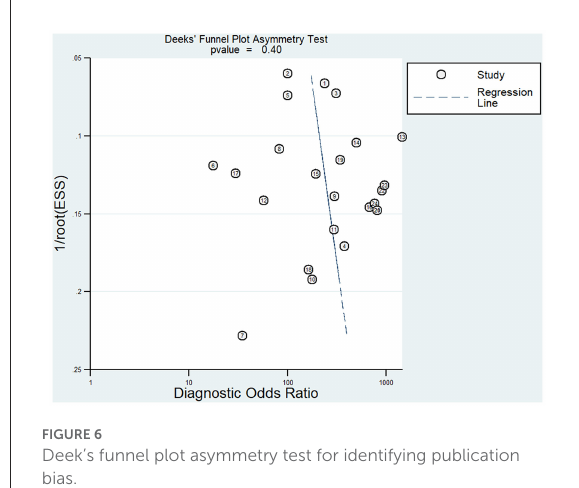
FIGURE5 Hierarchical summary receiver operating characteristic (HSROC) curve for evaluating the overall diagnostic performance of ADA for the diagnosis of abdominal TB.